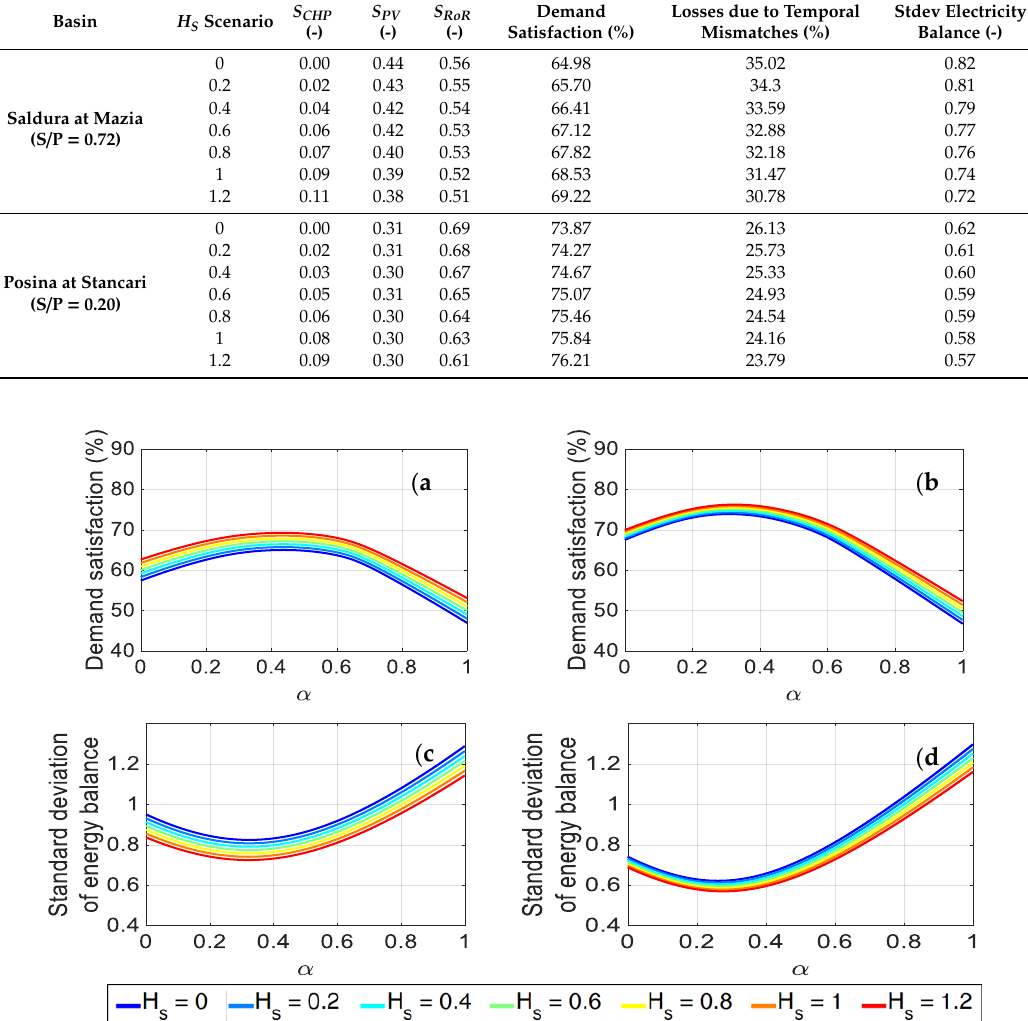
Table 2. E ff ect of CHP integration on demand satisfaction, variability of the electricity balance and contribution from solar PV and RoR hydropower electricity sources. Results are shown for two districts with di ff erent climate conditions; Saldura at Mazia (S / P = 0.72) and Posina at Stancari (S / P = 0.20). S CHP S PV S RoR Demand Losses due to Temporal Stdev Electricity Basin H S Scenario (-) (-) (-) Satisfaction (%) Mismatches (%) Balance (-)